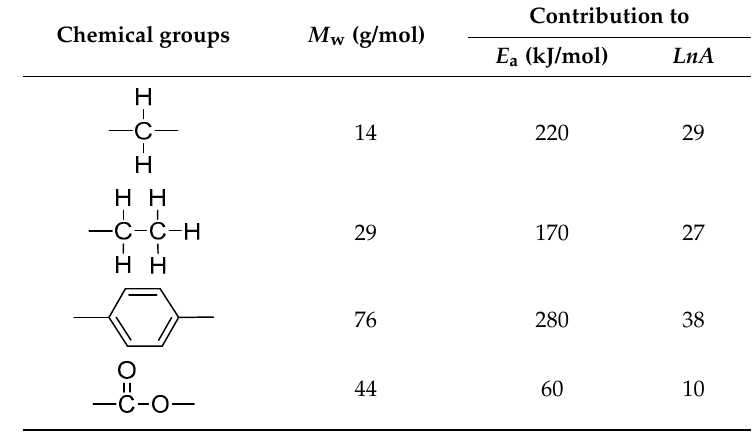
Figure 6. Experimental versus calculated activation energies for the studied polymers.